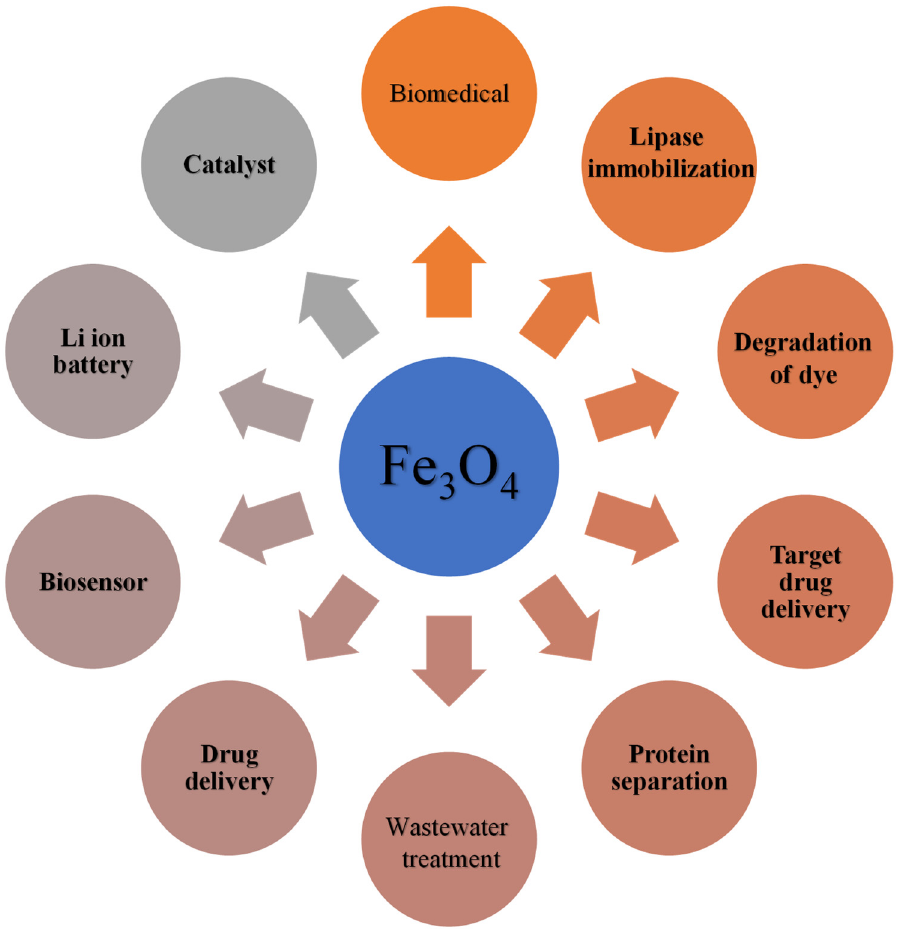
Figure 9. Applications of magnetite in various fields. Adapted with permission from [80]. Copyright, 2019 Springer.